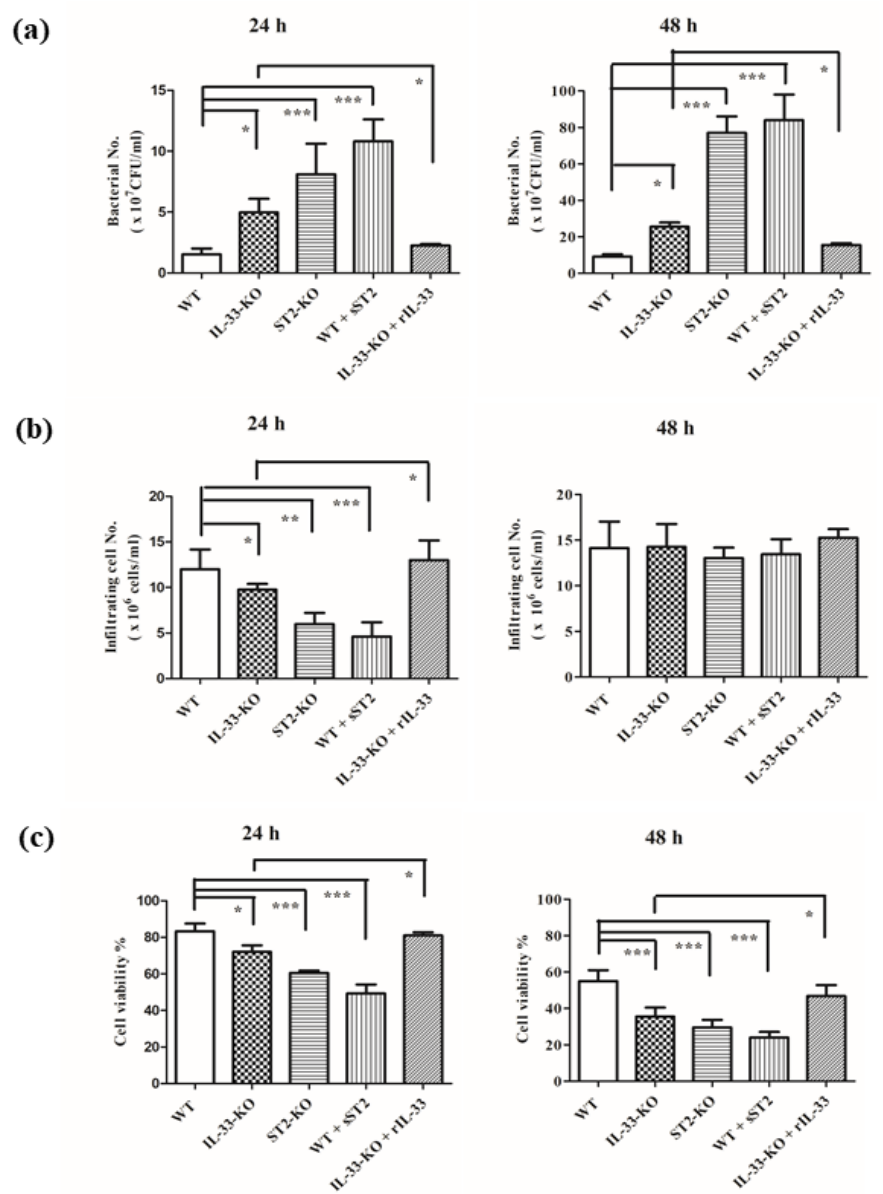
Figure 3. The bacterial loads, the numbers, and the cell viability of infiltrating cells in the air pouches of GAS-infected WT, IL - 33 -KO and ST2 -KO mice. Groups of four WT, IL - 33 -KO and ST2 -KO mice were inoculated via the intra-air pouch route with 2 × 10 8 S. pyogenes NZ131 cells per mouse. In one group, IL - 33 -KO mice were treated with rIL-33 (1 µ g per mouse) via the intra-air pouch route at 30 min before GAS infection and 24 h post-GAS infection. In the other group, WT mice were treated with sST2 fusion protein (1 µ g per mouse) via the intra-air pouch route at 30 min before GAS infection and 24 h post-GAS infection. At 24 h or 48 h post-infection, exudates of the air pouch were collected, and bacterial numbers ( a ), the numbers ( b ) as well as the cell viability ( c ) of infiltrating cells were counted, as described in Materials and Methods. The results are expressed as the mean ± standard deviation. The infiltrating cells in the air pouches of WT, IL - 33 -KO and ST2 -KO mice given PBS only, without GAS infection, were approximately (1.5 ± 0.3) × 10 4 cells/mL. The infiltrating cells in the air pouch of WT mice given sST2 were approximately (2.5 ± 0.4) × 10 4 cells/mL, while infiltrating cell numbers of B6 mice given rIL-33 were approximately (1.5 ± 0.5) × 10 6 cells/mL. Treatment groups were compared for significance using ANOVA. * p < 0.05, ** p < 0.01, *** p < 0.001 compared with the GAS-infected WT